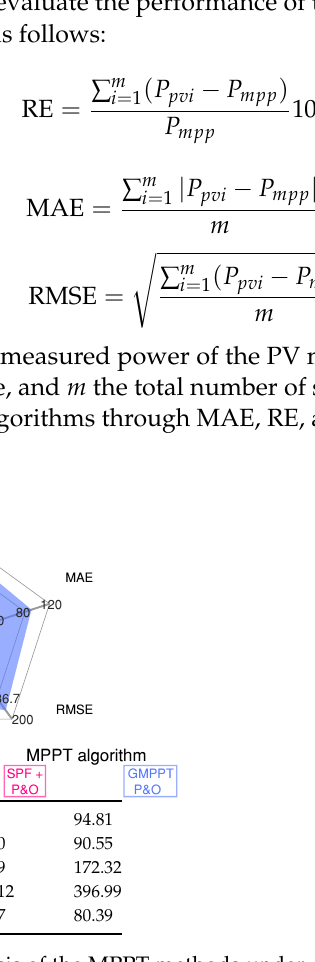
Figure 8. Comparative analysis of the MPPT methods under different uniform irradiance conditions for Scenario 2 shown in Figure